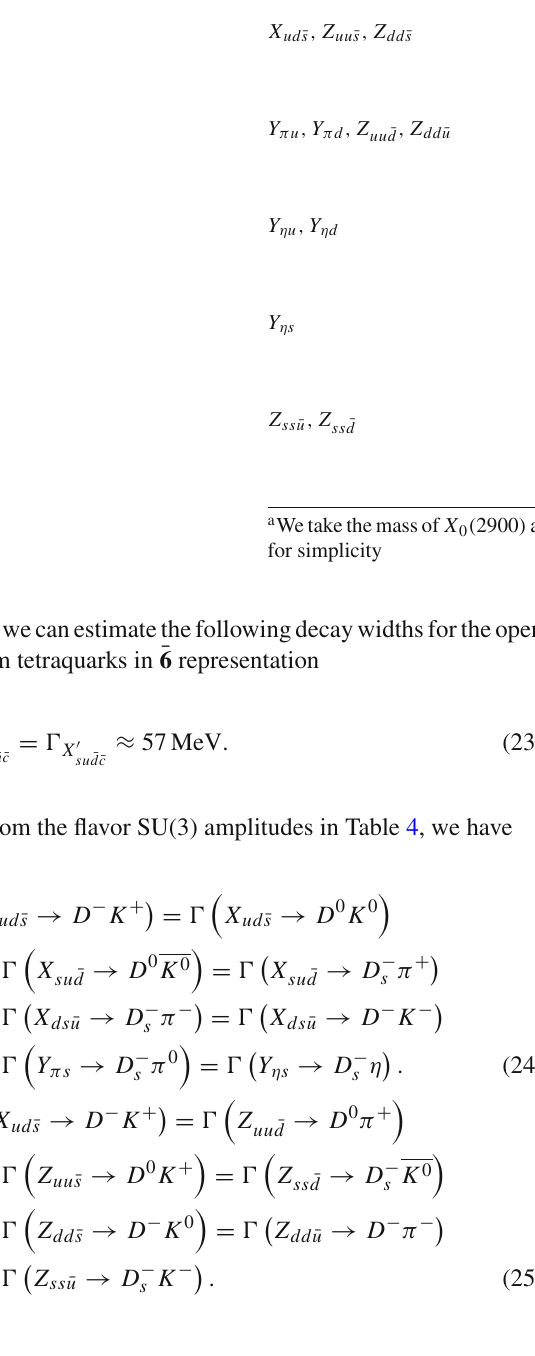
Table 2 Predictions of the masses (GeV) of radially excited X c ( b ) ( 2 S ) tetraquarks in both ¯ 6 and 15 representations. The uncertainty is from both the quark masses and slope parameter in Regge trajectories. The ground states of X c ( 1 S ) tetraquarks have been predicted in Ref.